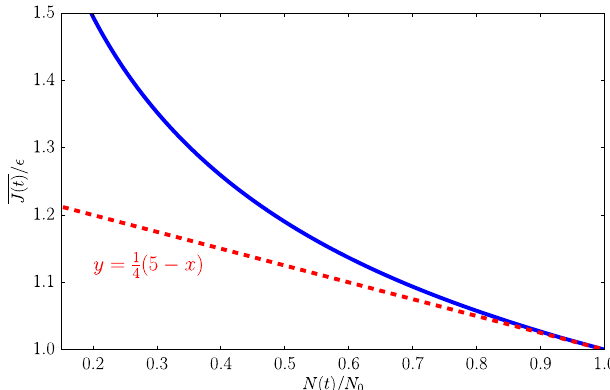
FIG. 4. Relative emittance growth versus remaining bunch intensity from analytical formula considering two transverse dimensions. In case synchrotron radiation damping is considered the ϵ in the vertical label means ϵ ð t Þ .